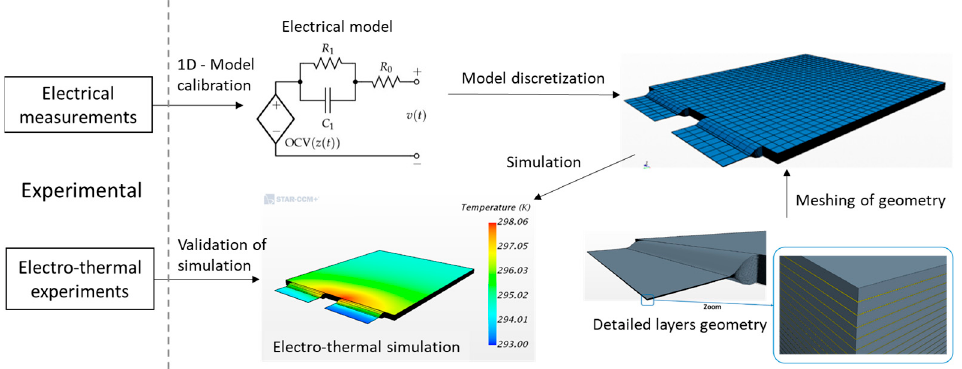
Figure 1. Schematic of the workflow strategy used for the cell testing, simulation and validation processes. On the left-hand side of the dotted line, the experimental section is divided in-to calibration and validation tests. On the right-hand side of the dotted line, the main steps of modeling process used to generate the electro-thermal model are shown.